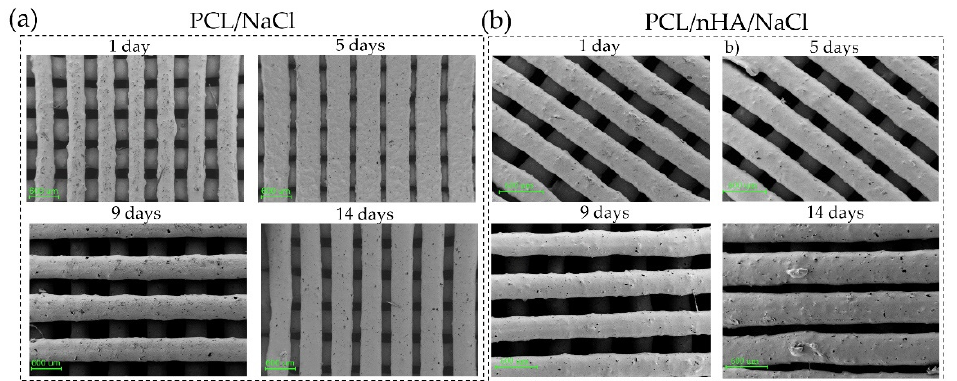
Figure 8. FE-SEM micrographs of pore formation at the surface level of ( a ) PCL/NaCl, and ( b ) PCL/nHA/NaCl scaffolds at 1, 5, 9, and 14 days.